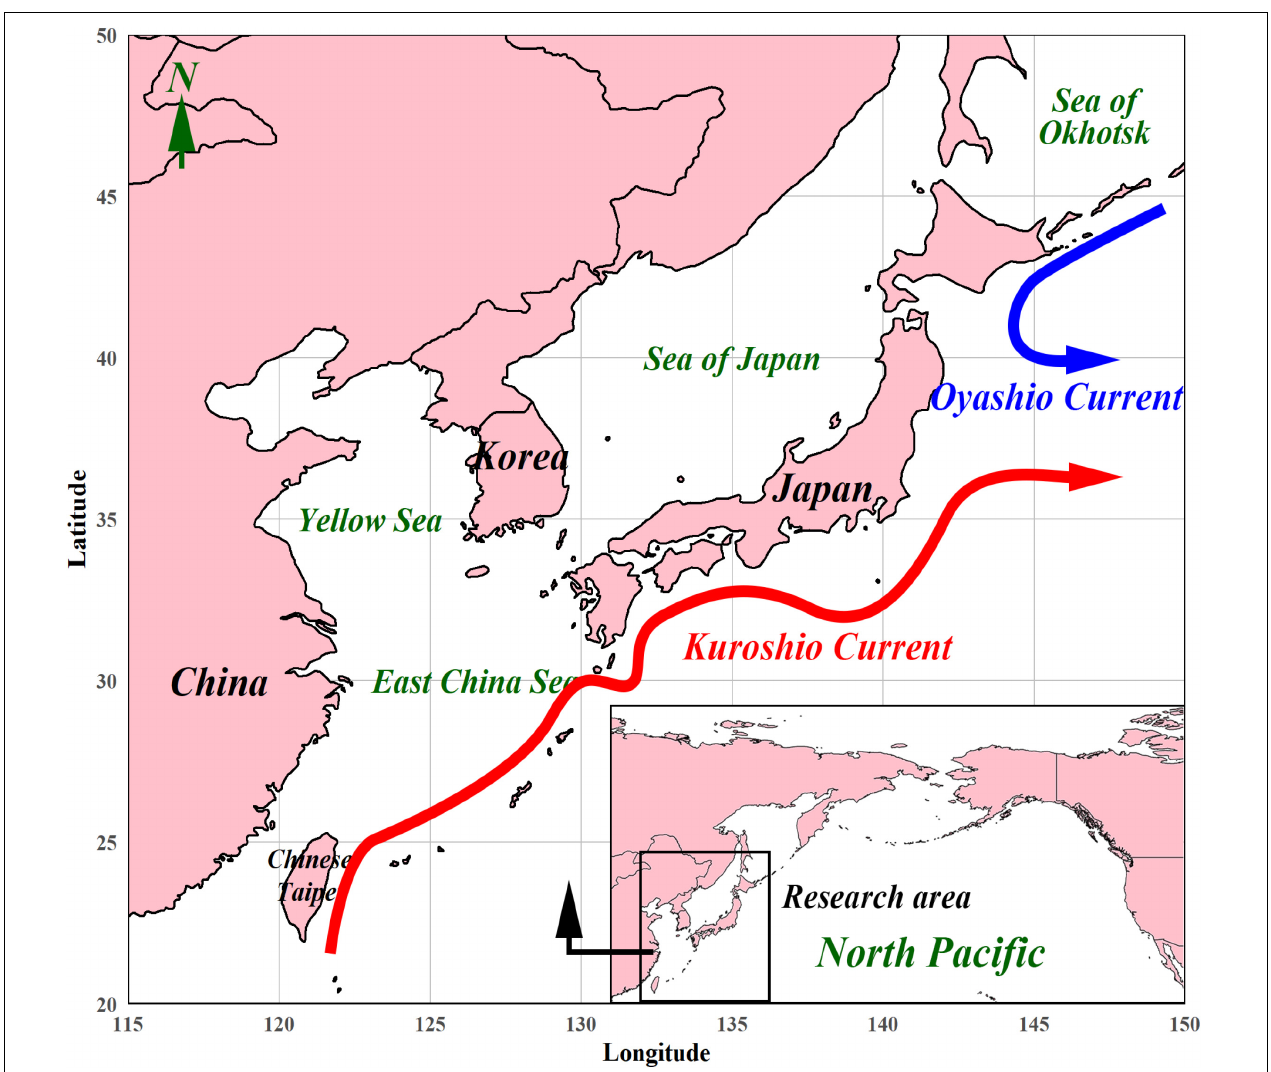
FIGURE 1 | Map of the northwestern North